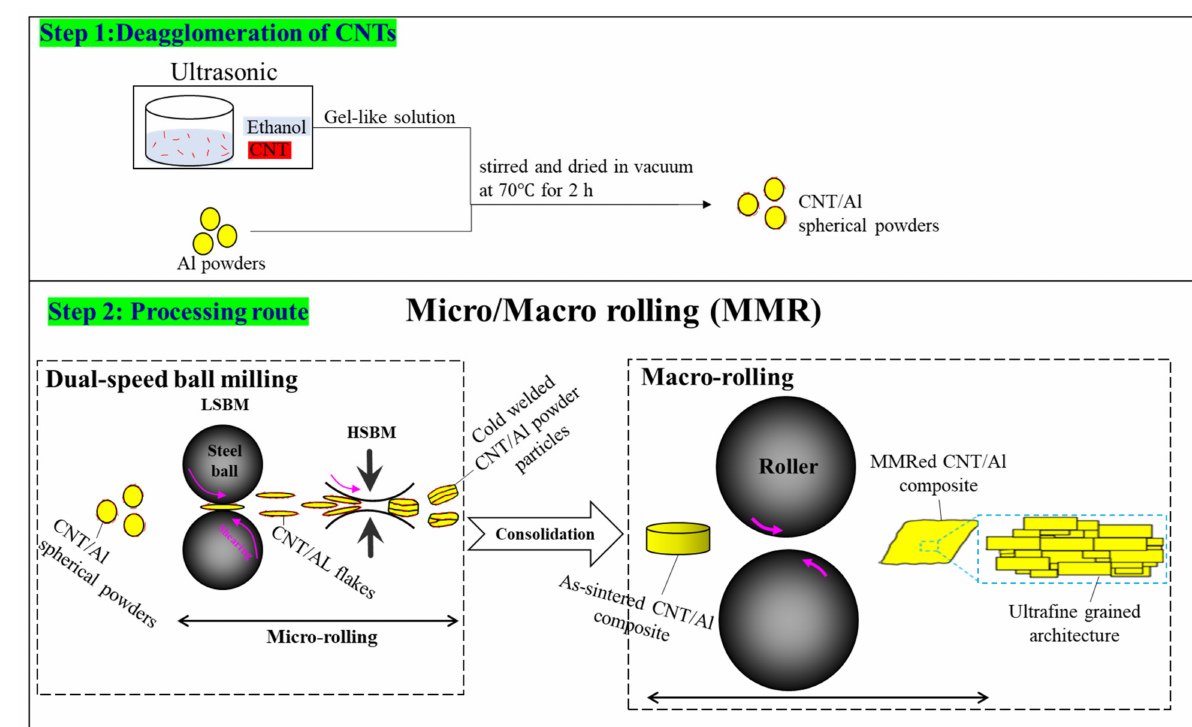
Figure 1. A schematic illustration of CNTs/Al composite production through dual-speed ball milling and conventional